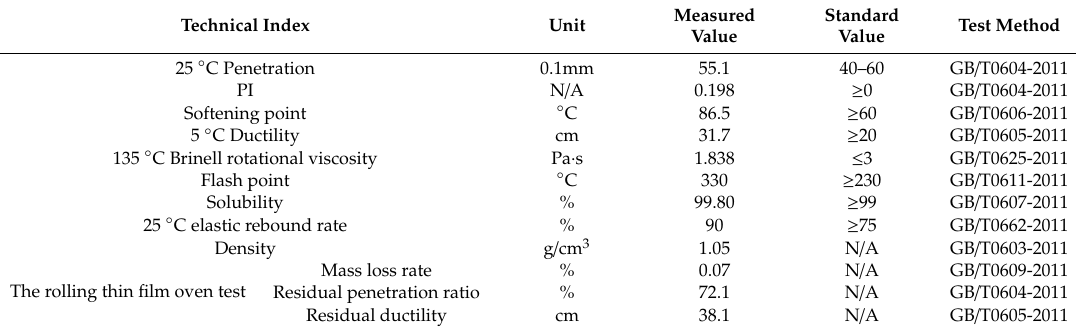
Table A7. Technical parameters of Styrene-Butadiene-Styrene modified asphalt.